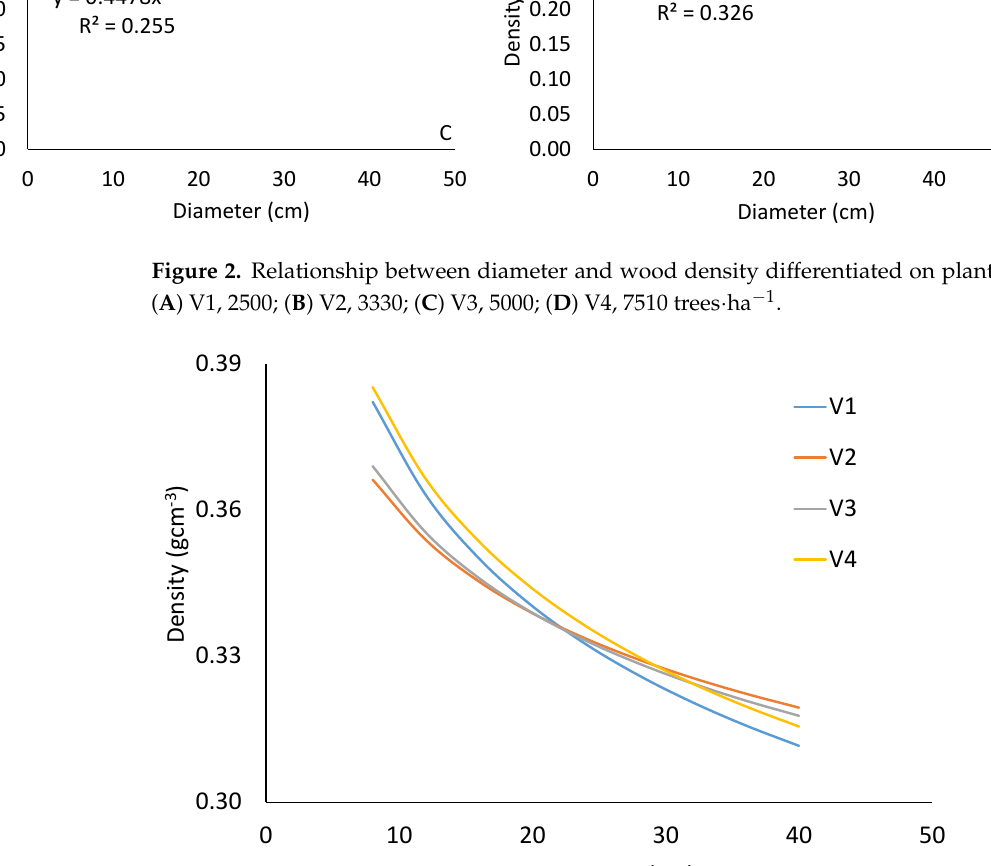
Figure 2. Relationship between diameter and wood density differentiated on plantation variants ( A ) V1, 2500; ( B ) V2, 3330; ( C ) V3, 5000; ( D ) V4, 7510 trees·ha − 1 .